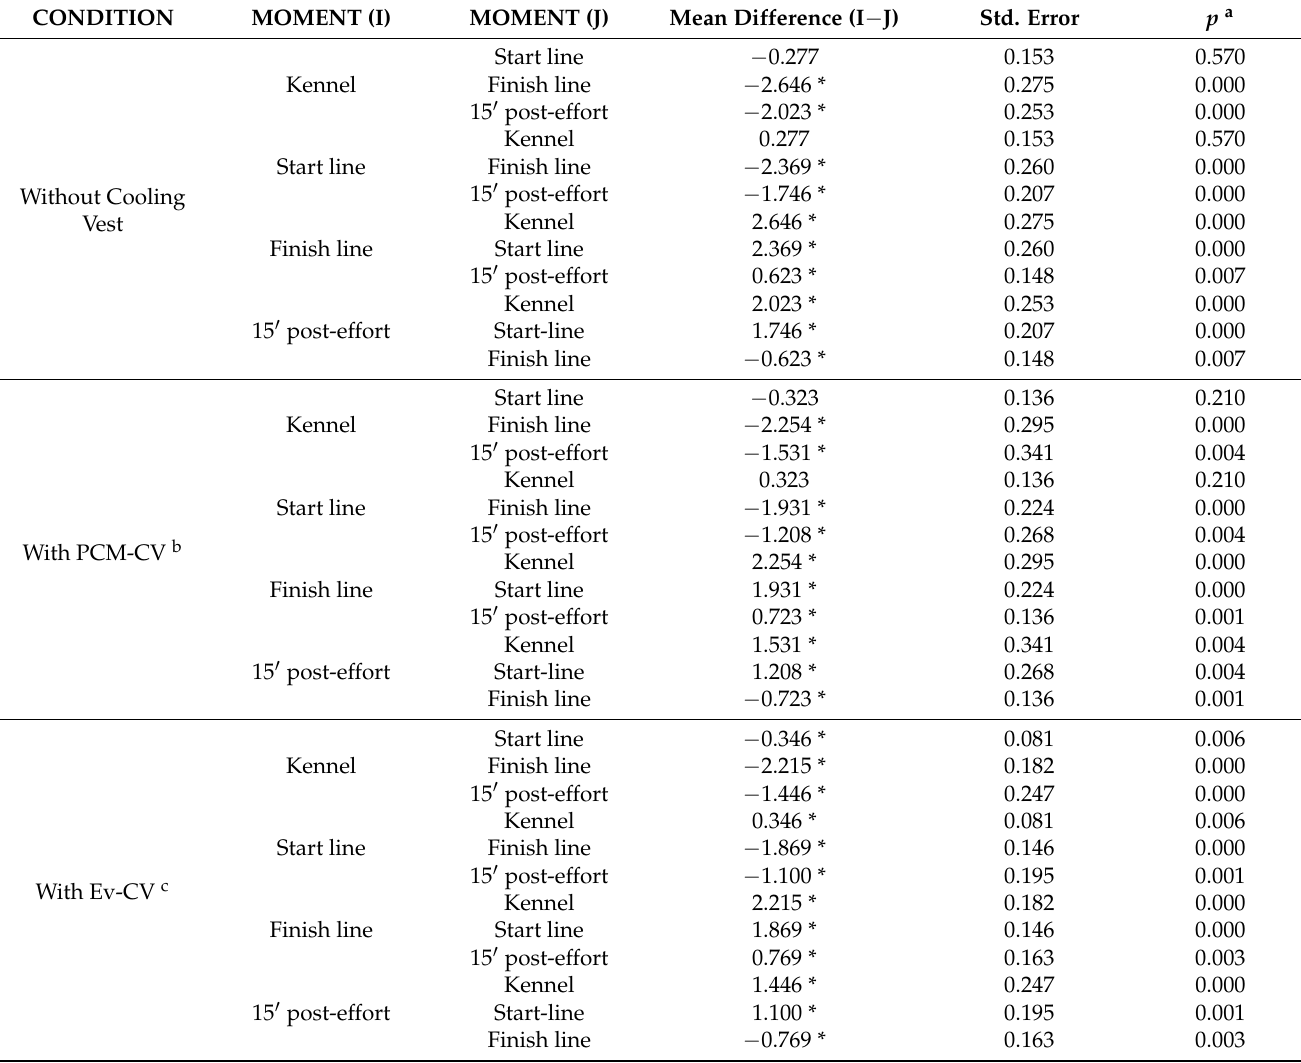
Table 9. Pairwise comparisons isolating the CONDITION factor. Measurement: